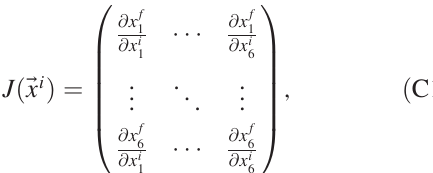
mines a position independent measure of the symplectic error. For the eighth order 4.155 MV map this is given by 6 . 05 × 10 − 13 . The fact that this value is greater than double precision would suggest that the symplectic error would have a visible effect in the numerical tracking at a faster rate than with symplectic numerical tracking. However, such an evaluation does not equate to a quantifiable effect in terms of error in tracking; therefore, it is impossible to judge the impact of the symplectic error without experimentally testing the Taylor map in long-term tracking. If a Taylor map ’ s symplectic error were small, it would be expected that it would give a good agreement for some finite number dynamics.